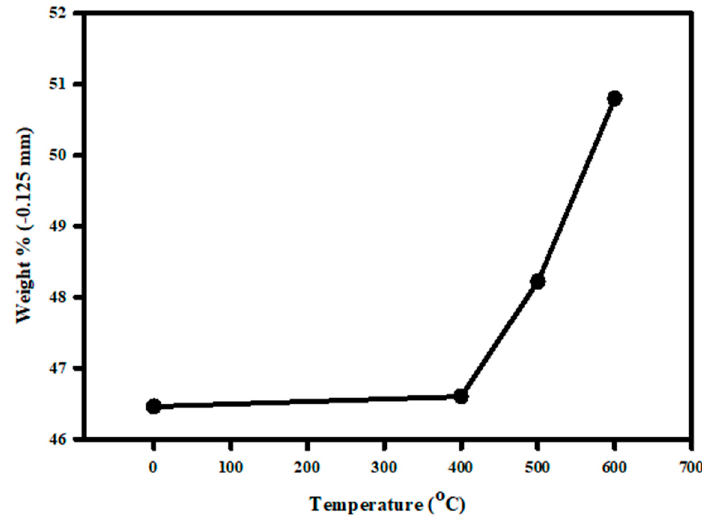
Figure 4. E ff ect of thermal treatment via furnace on iron ore grinding (100 g, 2.45 GHz, and 1 h) (data source: [34]).